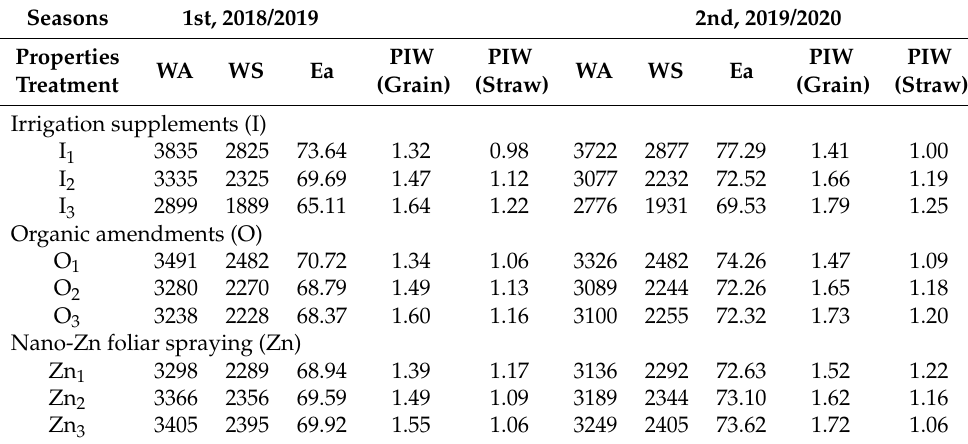
Table 5. The mean performance of total water applied, stored water, water application efficiency, and irrigation water productivity of grain and straw as affected by different treatments (irrigation supplements, organic amendments, and nano-Zn foliar